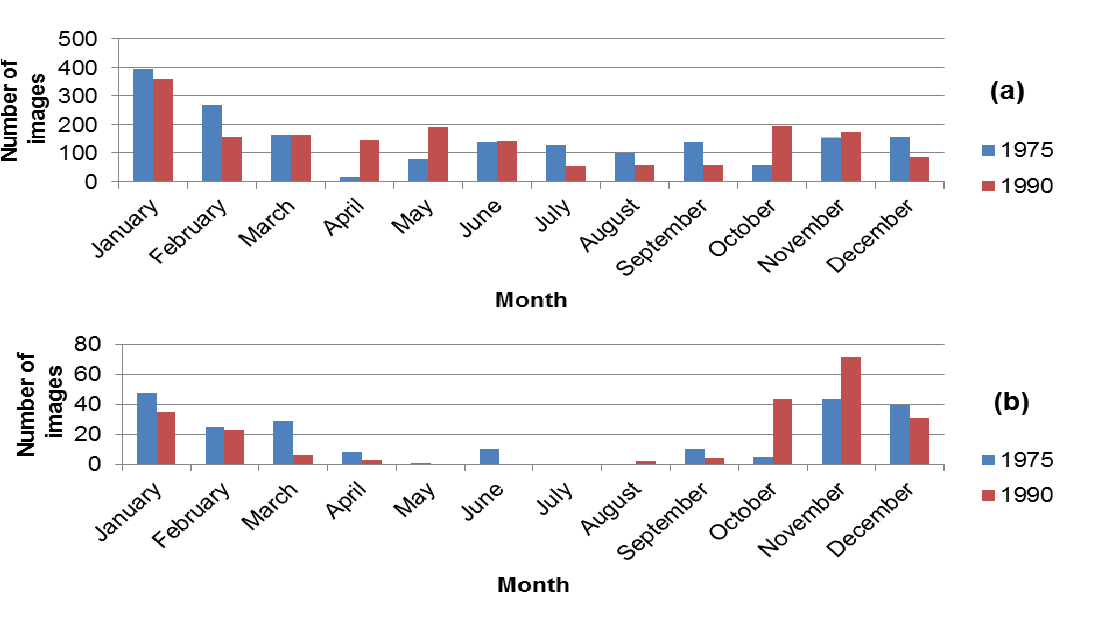
Figure 5. Comparison of acquisition months of the best candidates selected for Landsat MSS (around 1975) and TM images (around 1990) for ( a ) the whole sub-Saharan Africa ( n = 1,799), and only for ( b ) West Africa ( n =